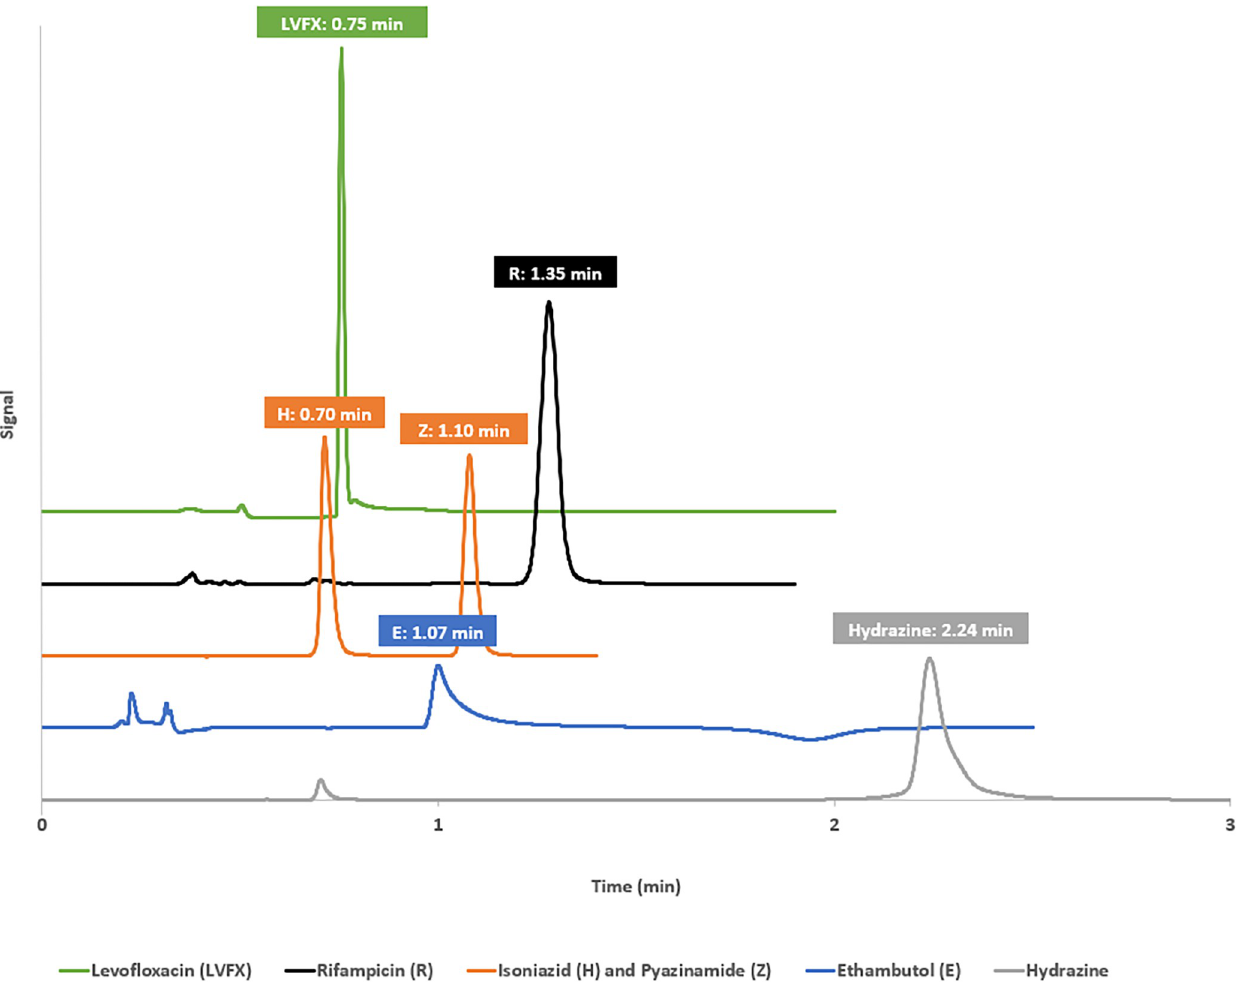
Fig 1. Chromatographs and retention times for levofloxacin (LVFX), rifampicin (R), isoniazid (I), pyrazinamide (Z), ethambutol (E) and hydrazine.